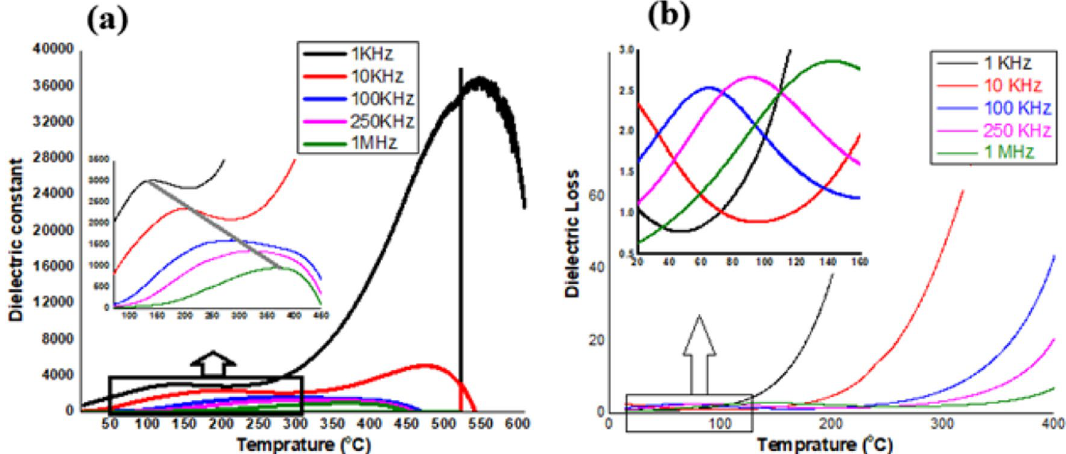
Figure 3. ( a ) Variation of dielectric constant ( a ) and dielectric loss ( b ), at various frequencies and varying temperatures (25–600 °C). ( b ) zoomed region of ( a ) with temperature range (25 to 400 °C).